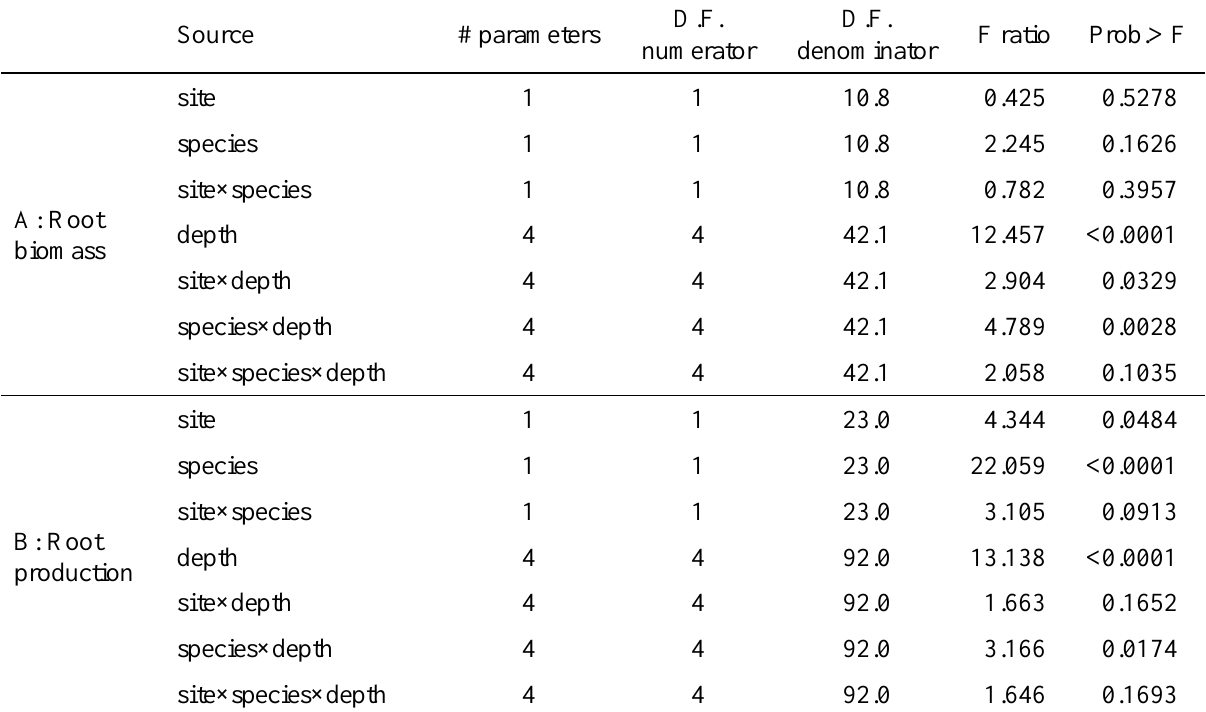
Table 2. Fixed effect results of full factorial mixed models performed on (A) root biomass, and (B) root production. Fixed effects: species, site, depth. Random effects: core in